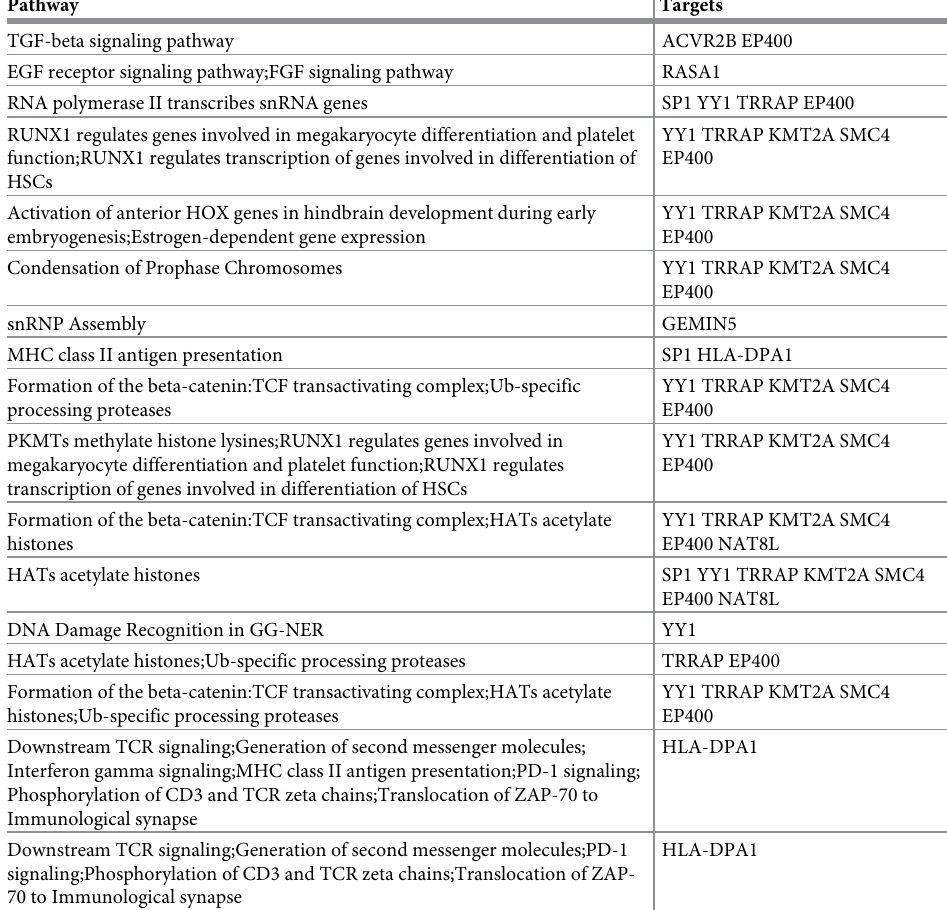
Table 4. Enriched pathways of POGZ with associated significant best